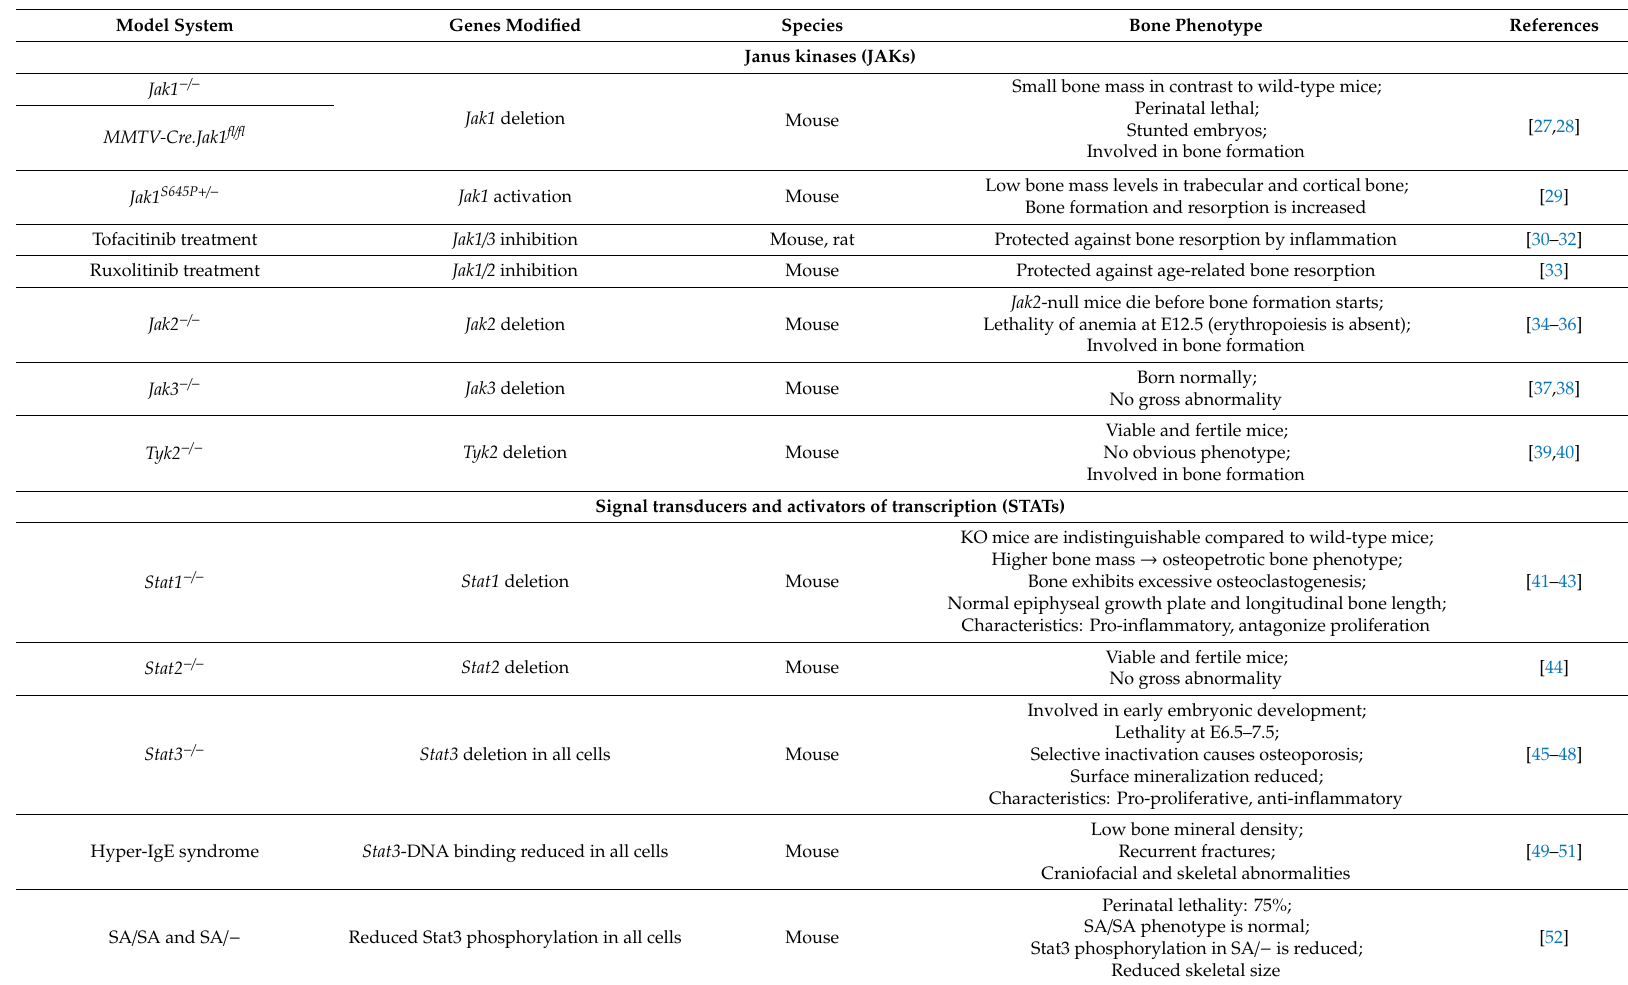
Table 1. JAK / STAT pathway in bone